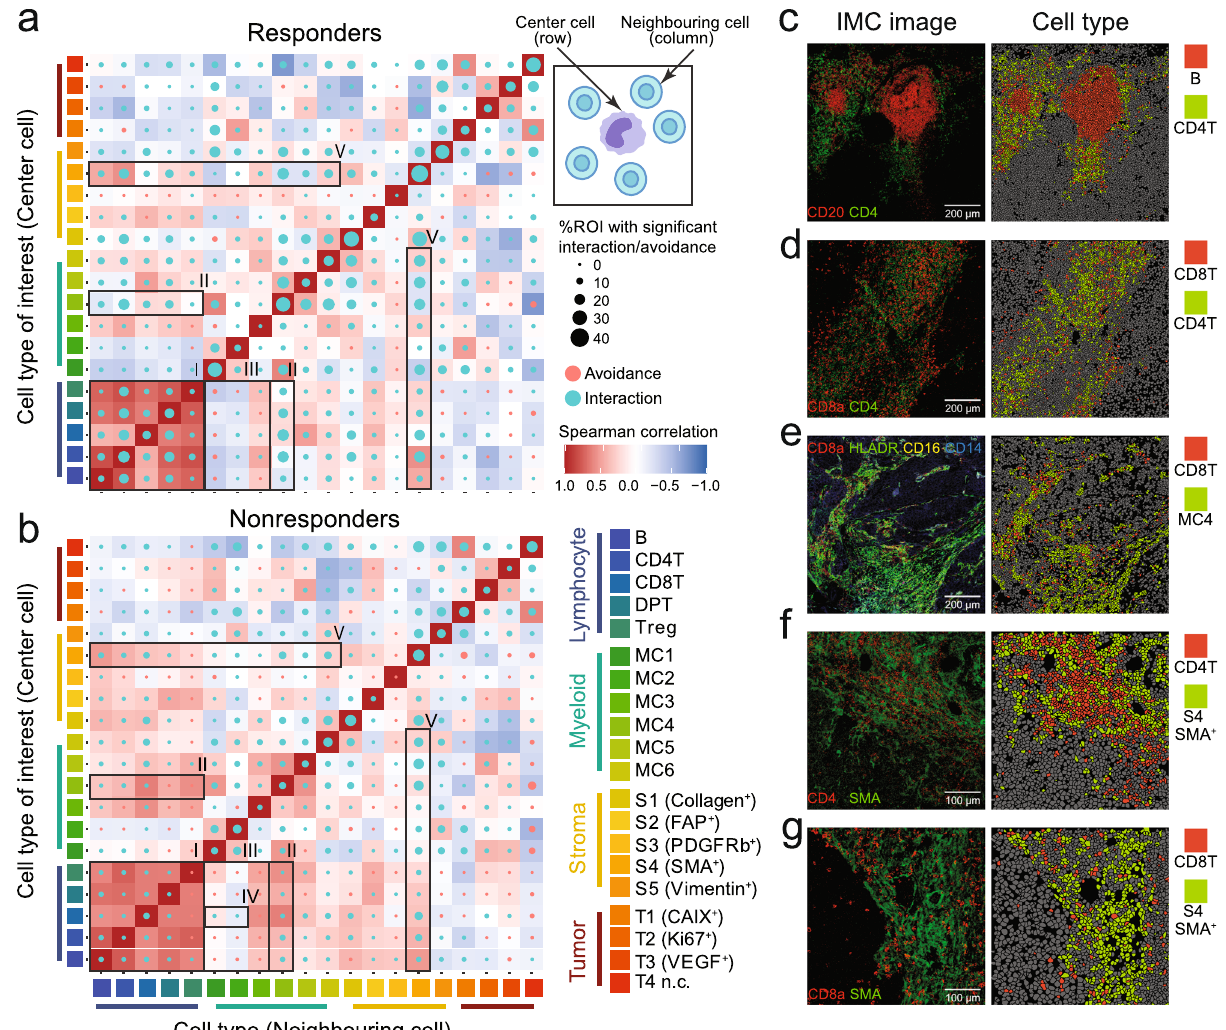
Fig. 3 Spatial analysis among cell phenotypes. a , b Circles indicating patterns of cell – cell interactions (green) or avoidances (red) for responders ( n = 99 ROIs) ( a ) and nonresponders ( n = 59 ROIs) ( b ). The circle size showing the percentage of images with signi fi cant interaction or avoidance determined by the permutation test ( P < 0.01). Rows representing the relationship of all other cell types surrounding a cell type of interest. Columns representing the relationship of a cell type of interest surrounding other cell types. Color in heatmap squares indicating Spearman ’ s rank correlation of cell types across all imaging mass cytometry (IMC) images in responders and nonresponders. Highlighted interactions or avoidance (numbered black boxes) include: (I) lymphocytes; (II) MC4 cells and lymphocytes; (III) HLA-DR − myeloid cells and lymphocytes; (IV) MC1/MC2 cells and CD8 + T cells; (V) stromal SMA + cells and immune cells. c – g Representative IMC images colored by marker (left columns) and cell type (right columns) showing the cell – cell interactions: c B cells are surrounded by CD4 + T cells, d CD8 + T cells are surrounded by CD4 + T cells, e CD8 + T cells are surrounded by MC4 cells, f CD4 + T cells are surrounded by SMA + stromal cells, g CD8 + T cells are surrounded by SMA + stromal cells. MC1: HLA-DR − CD14 + CD11c + myeloid cells, MC2: HLA-DR − CD14 + myeloid cells, MC3: HLA-DR − CD11b hi myeloid cells, MC4: HLA-DR hi CD14 hi CD16 + CD11c + CD11b + myeloid cells, MC5: HLA-DR